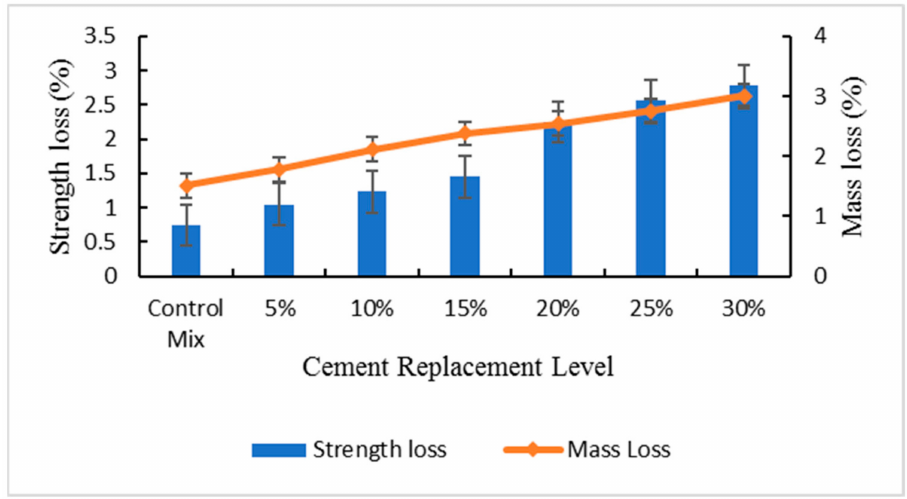
Figure 14. Compressive strength and mass loss in chloride environment (90